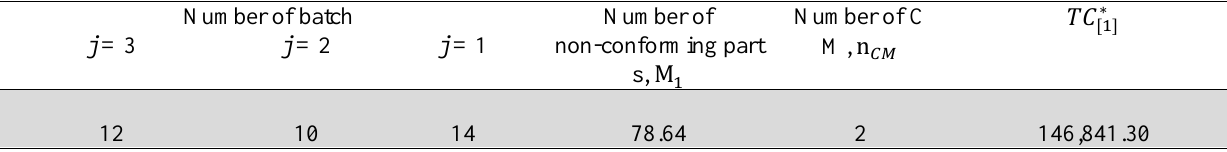
The decision variable of the best solution for 1 st looping ( k = 1) Number of batch Number of